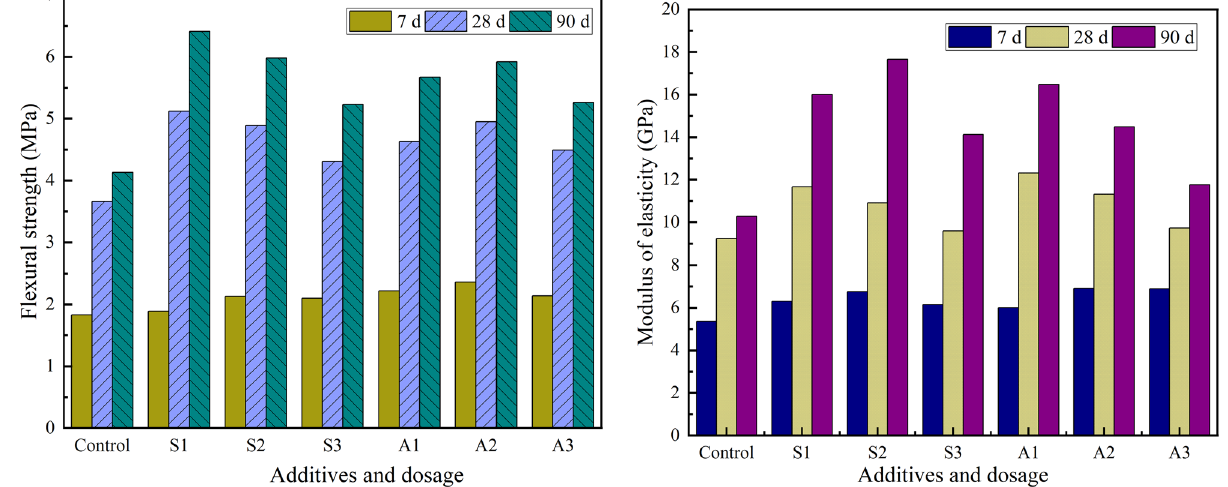
Figure 7: Modulus of elasticity of geopolymer pastes [ 41 ] . Figure 5: Flexural strength of geopolymer pastes [ 41 ] .